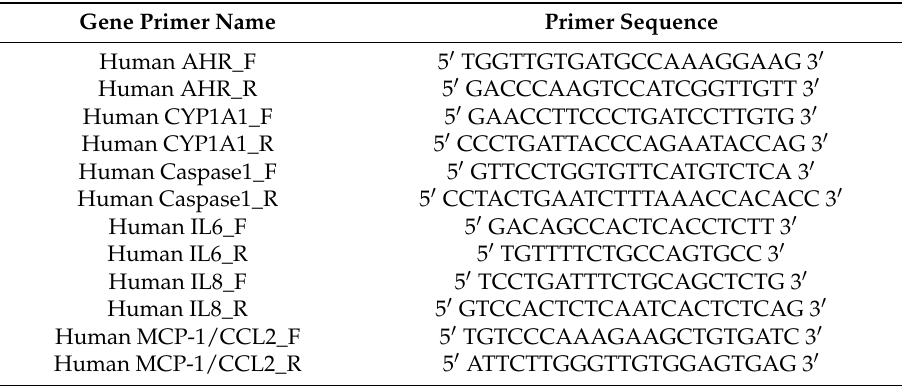
Table A2. Primers used in this